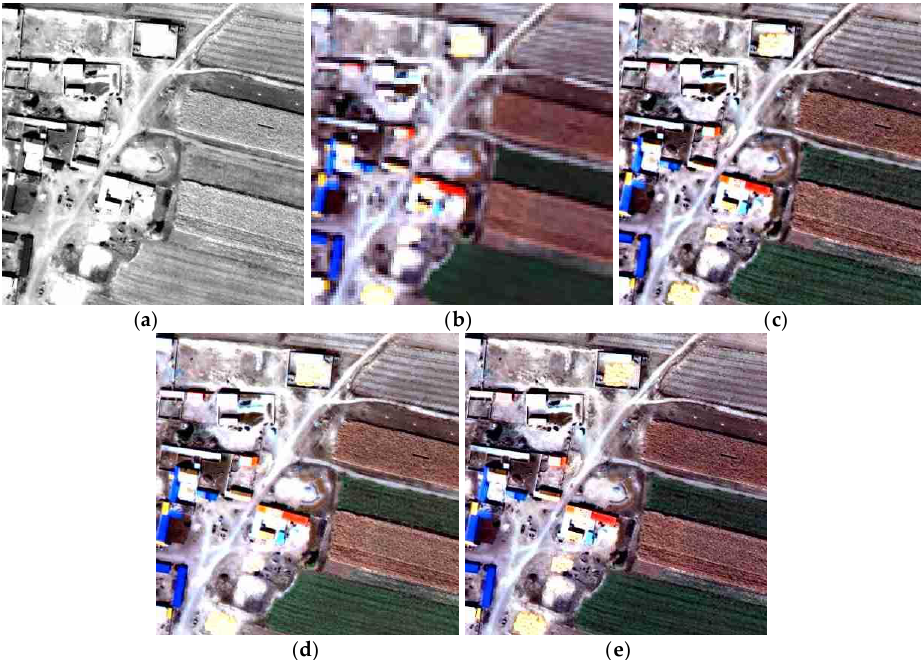
Figure 5. The details of pansharpened images according to each algorithm in the Baotou region: ( a ) panchromatic image; ( b ) resized multispectral image; ( c ) image pansharpened by the MTF-GLP method; ( d ) image pansharpened by the GSA method; ( e ) image pansharpened by the GFNDVI.